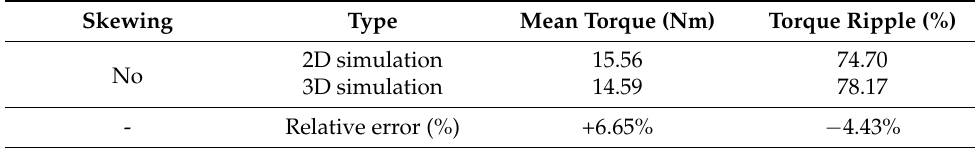
Table 2. Mean torque, torque ripple, and relative errors between 2D and 3D simulations.